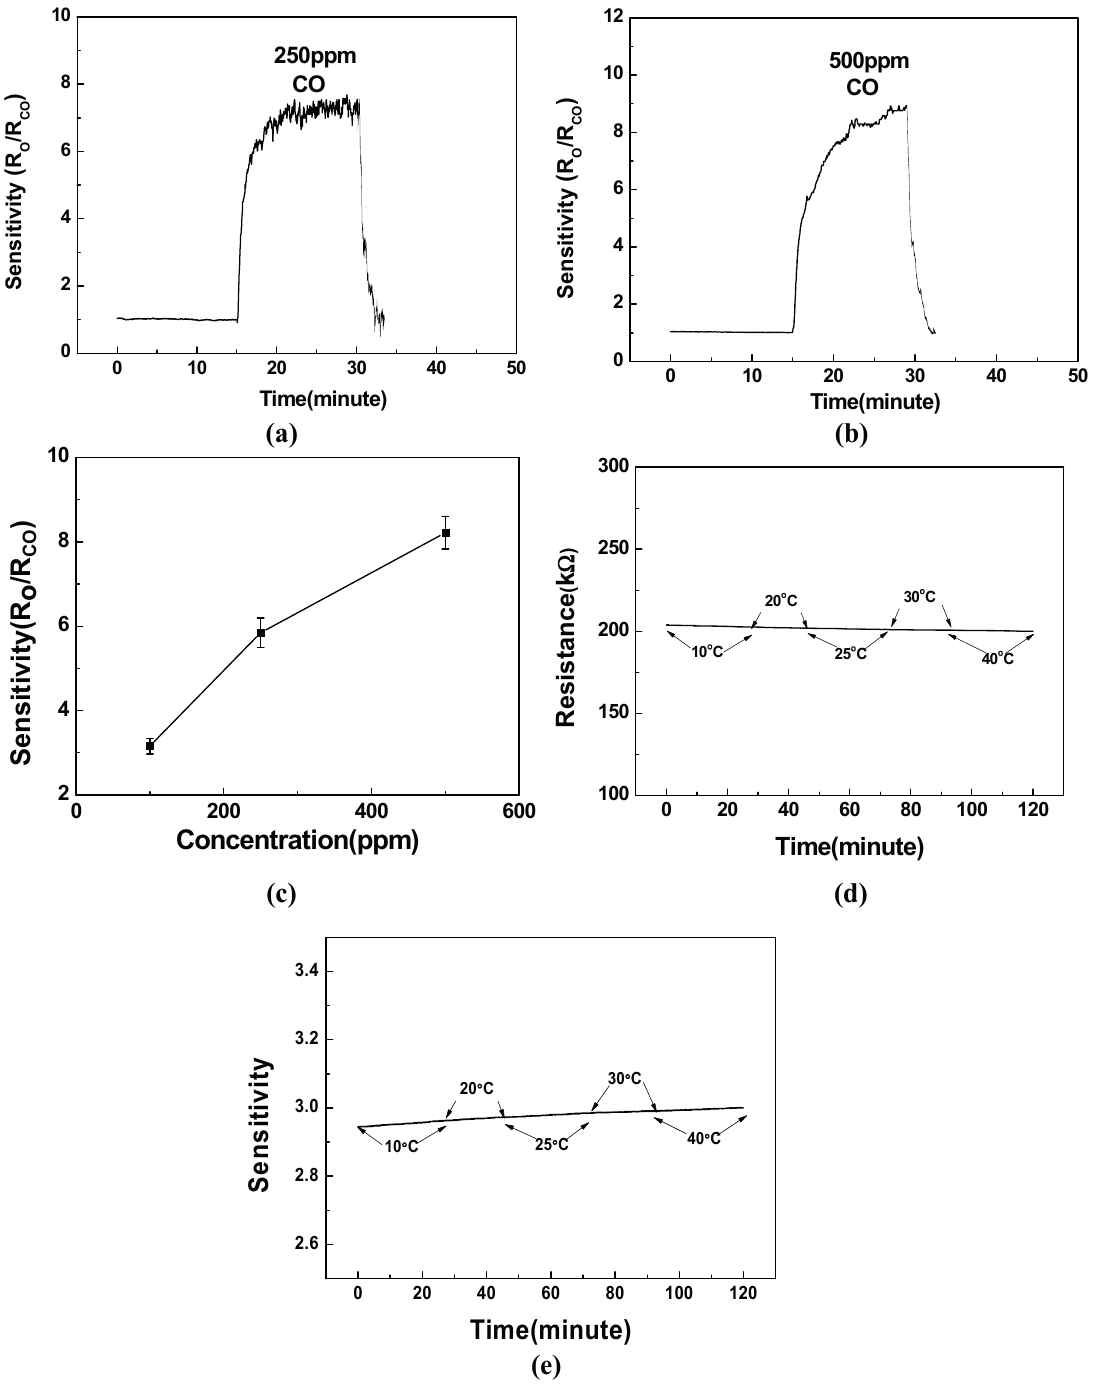
Figure 7. ( a ) Temporal CO sensing measurement results at the room temperature for 250 ppm CO; ( b ) temporal CO sensing measurement results at the room temperature for 500 ppm CO; ( c ) measured mean peak sensitivities with different CO concentrations; ( d ) measured temperature dependence of the fabricated gas sensor’s resistance; ( e ) measured temperature dependence of the fabricated gas sensor’s